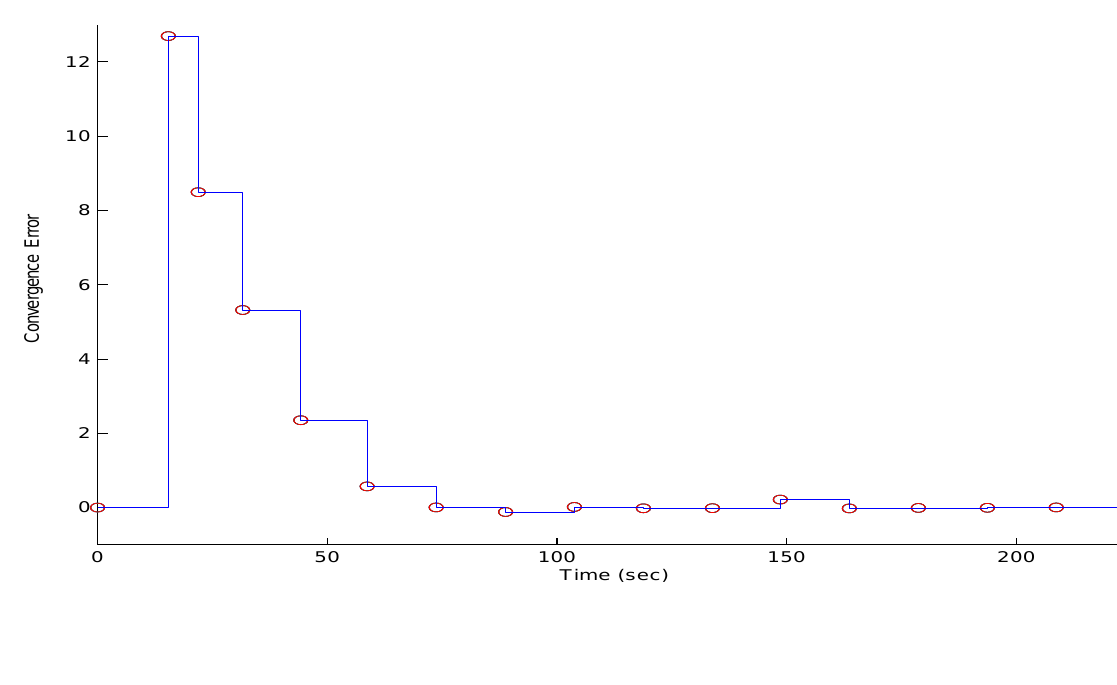
Figure 22 . Initial Transmitted Image Frame ( t = 0 s—left side)—Converged Transmitted Image Frame ( t = 225 s—right side) under 10% Network